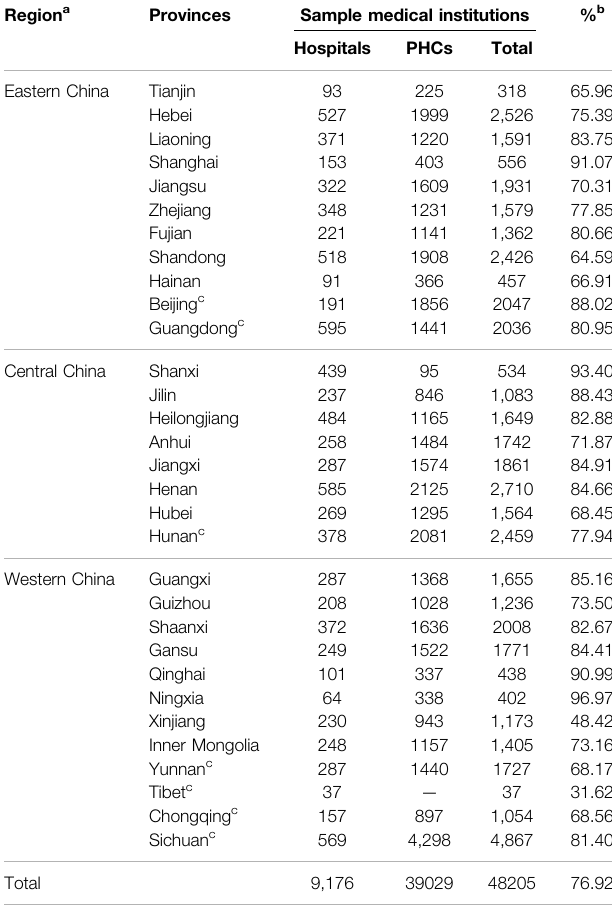
TABLE 1 | Distribution of sample medical institutions. Region a